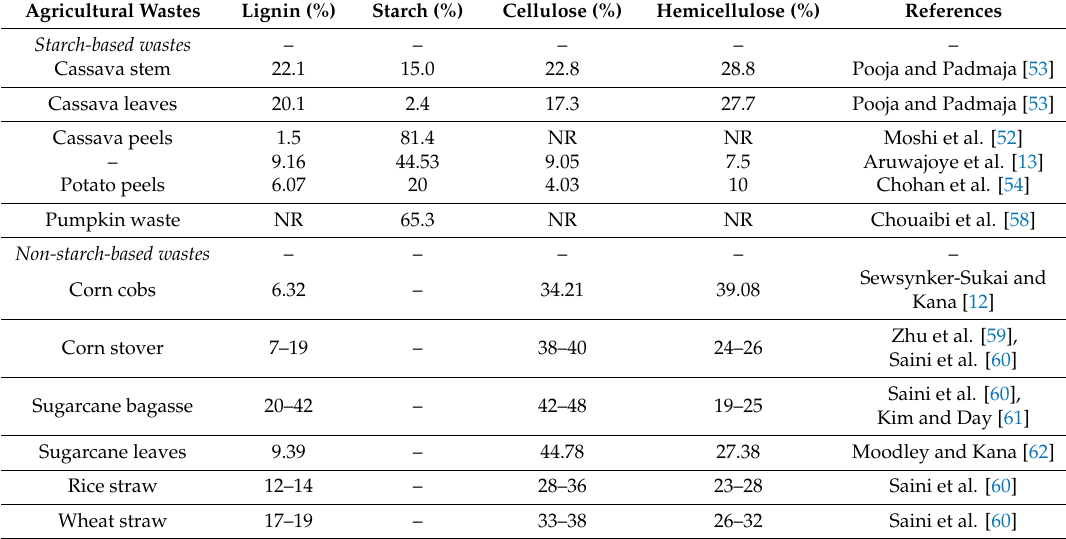
Table 2. Biochemical composition of starch-based wastes and non-starch-based wastes.